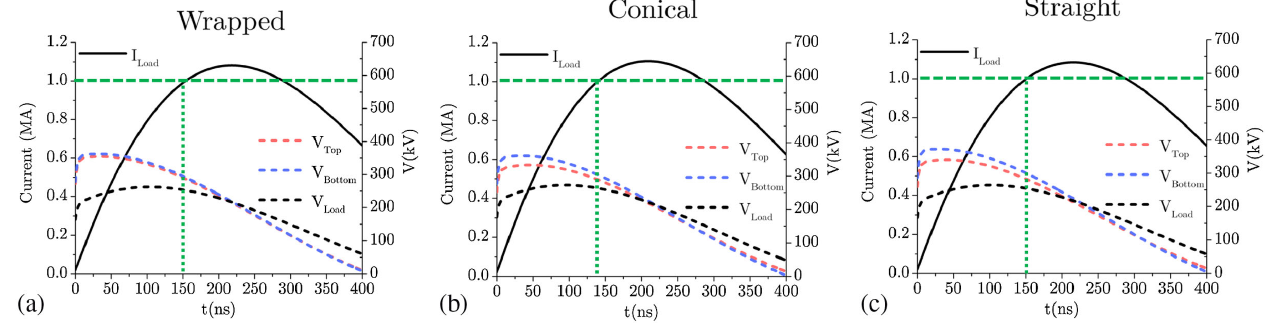
FIG. 6. SPICE simulations for (a) wrapped, (b) conical, and (c) straight transmission